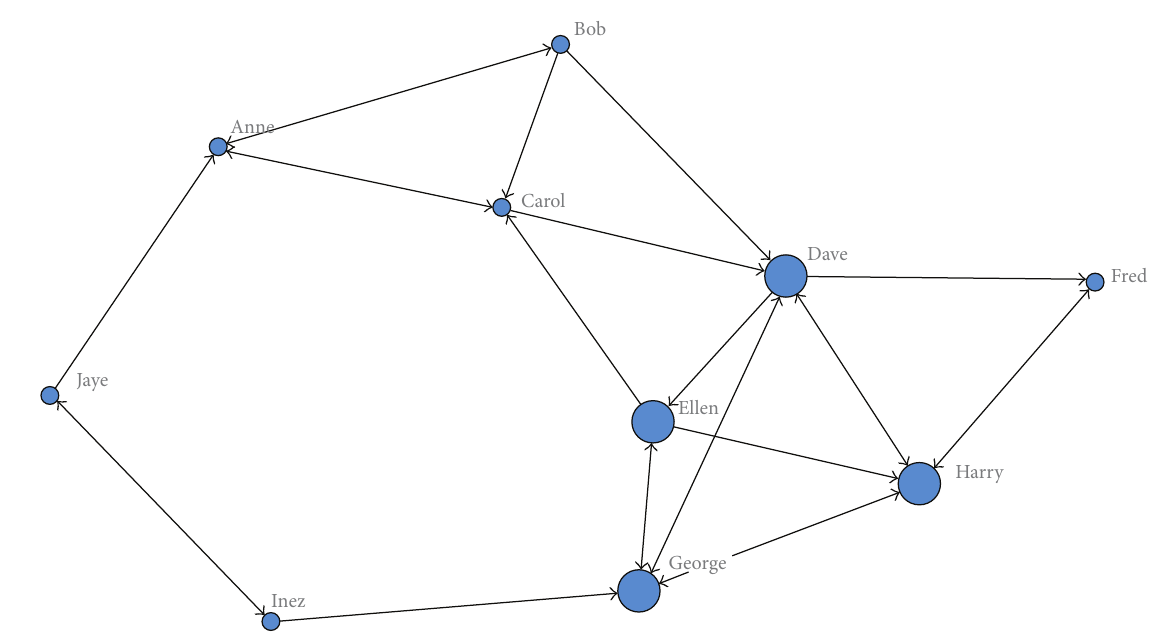
Figure 2: Topological clustering results of EZ